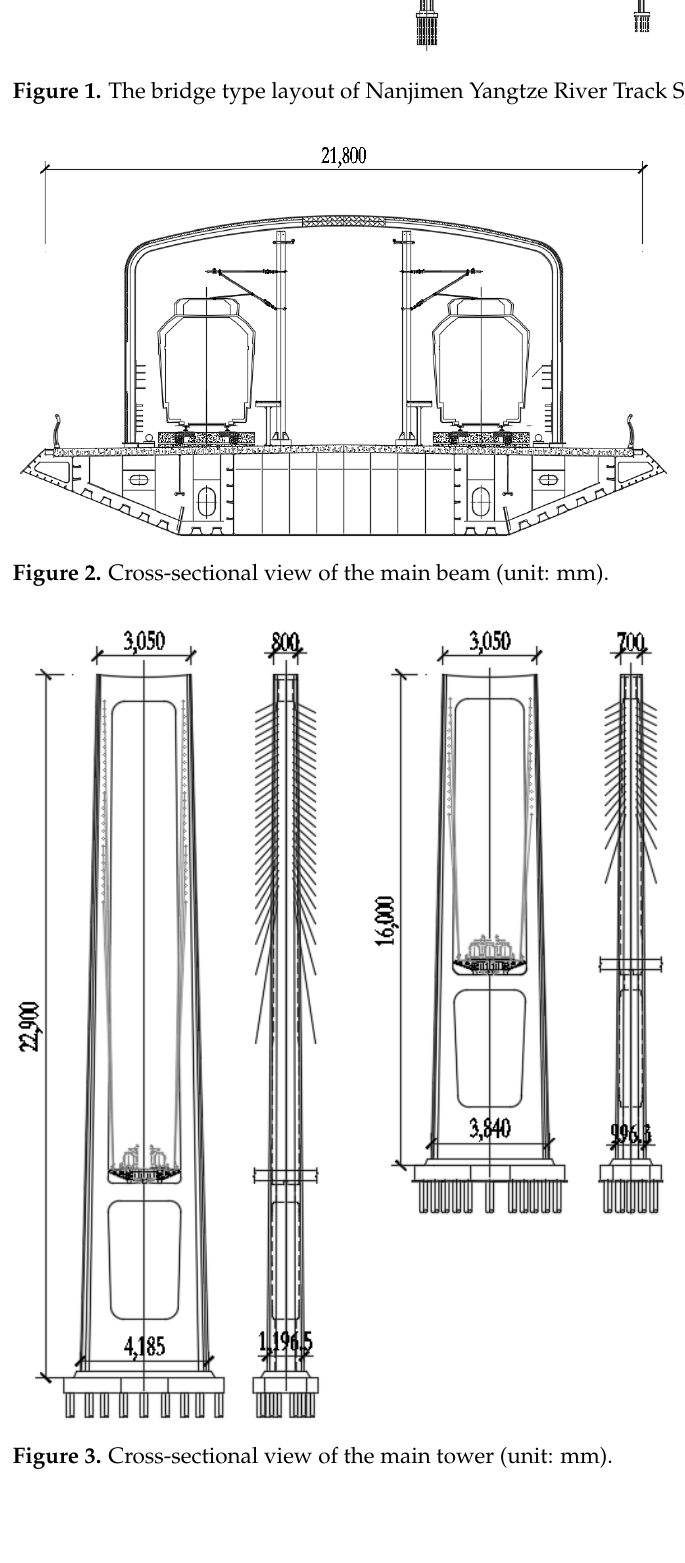
Figure 4. Cross-sectional view of the cable.